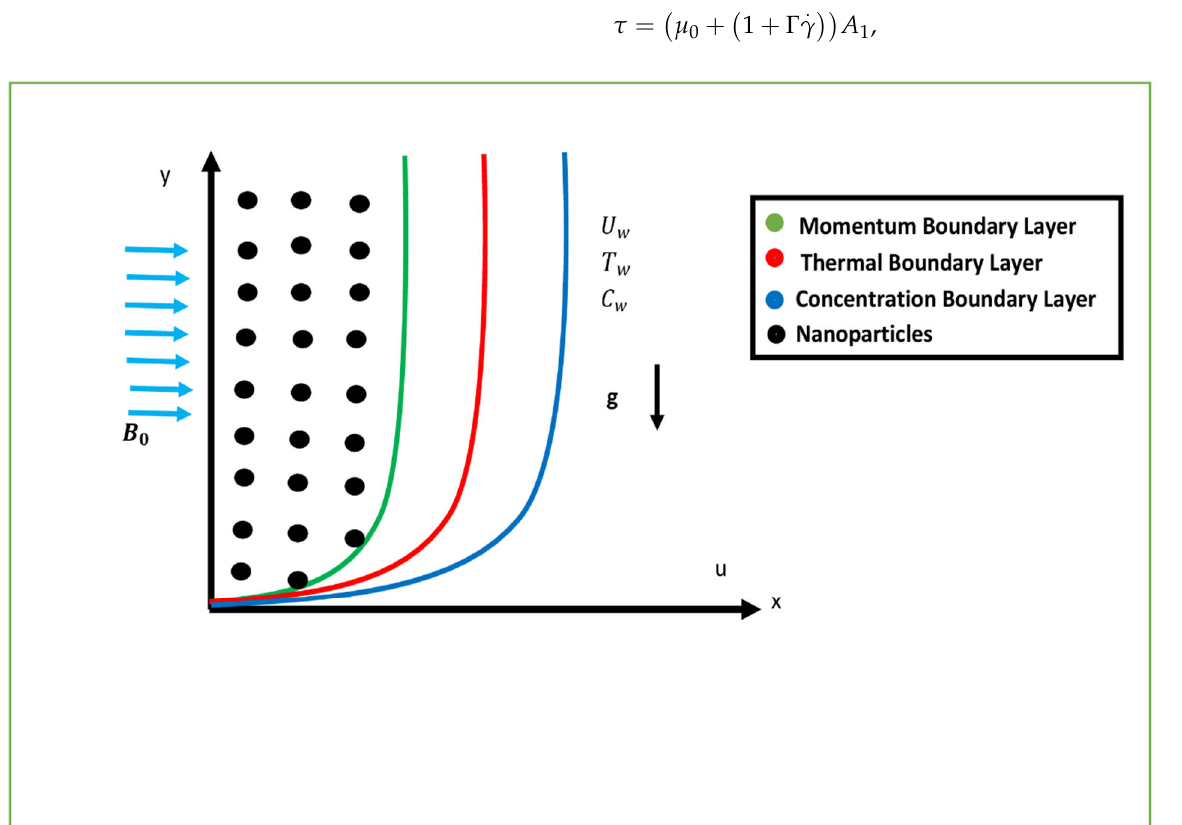
Figure 1. Schematic geometry of the flow problem. U w stands for the velocity at the wall, T w denotes the wall’s temperature, C w denotes the concentration at the wall, g denotes the gravitational acceleration, and B 0 denotes the applied magnetic field.